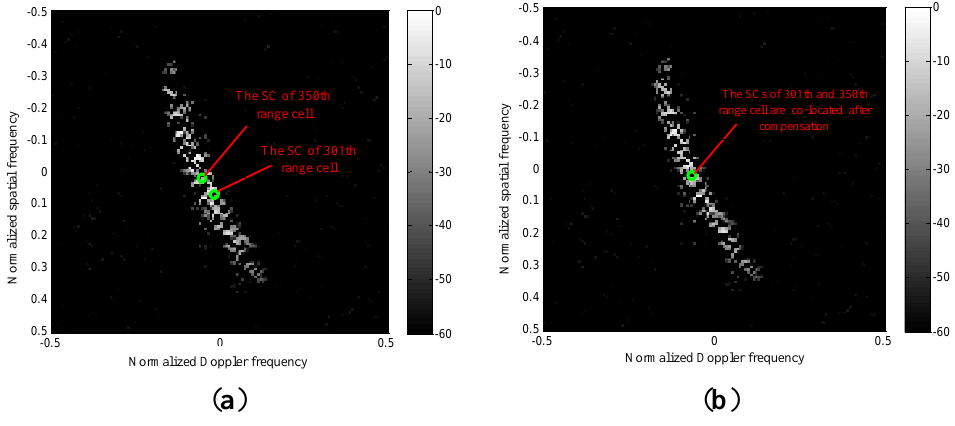
Figure 6. Spectrum of different range cells. ( a ) W ithout compensation; ( b ) Using EAADC approach. IF is another common metric to evaluate the capability to compensate the clutter SCs